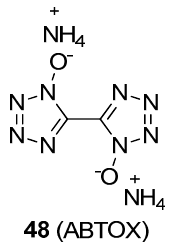
Figure 5. ABTOX (48), a decomposition product of TKX-50.